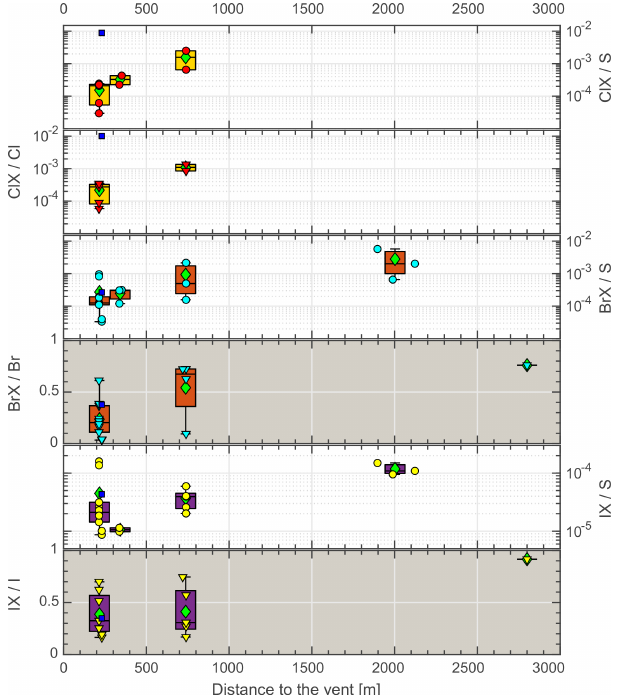
Figure 4. Reactive halogen species (RHS) progression during plume aging. Note the non-logarithmic scale (gray background). Circles denote the Hal / S ratio, triangles denote the Hal X / Hal ra- tio, diamonds denote the mean, the boxes show the 25th and 75th percentiles and the median, blue squares denote night samples (not included in mean and median